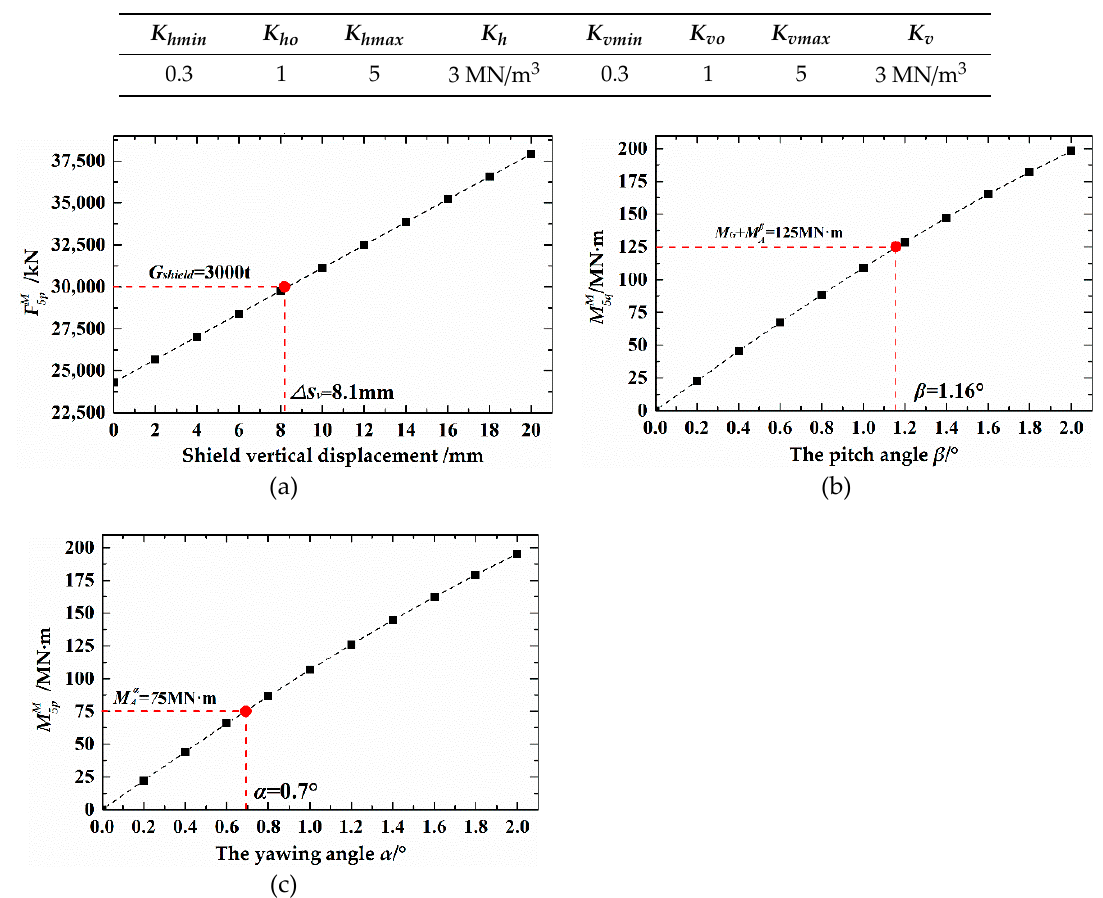
Figure 12. Calculation of shield attitude parameters: ( a ) Stage 1, solving △ s v ; ( b ) Stage 2, solving β ; and ( c ) Stage 3, solving α .